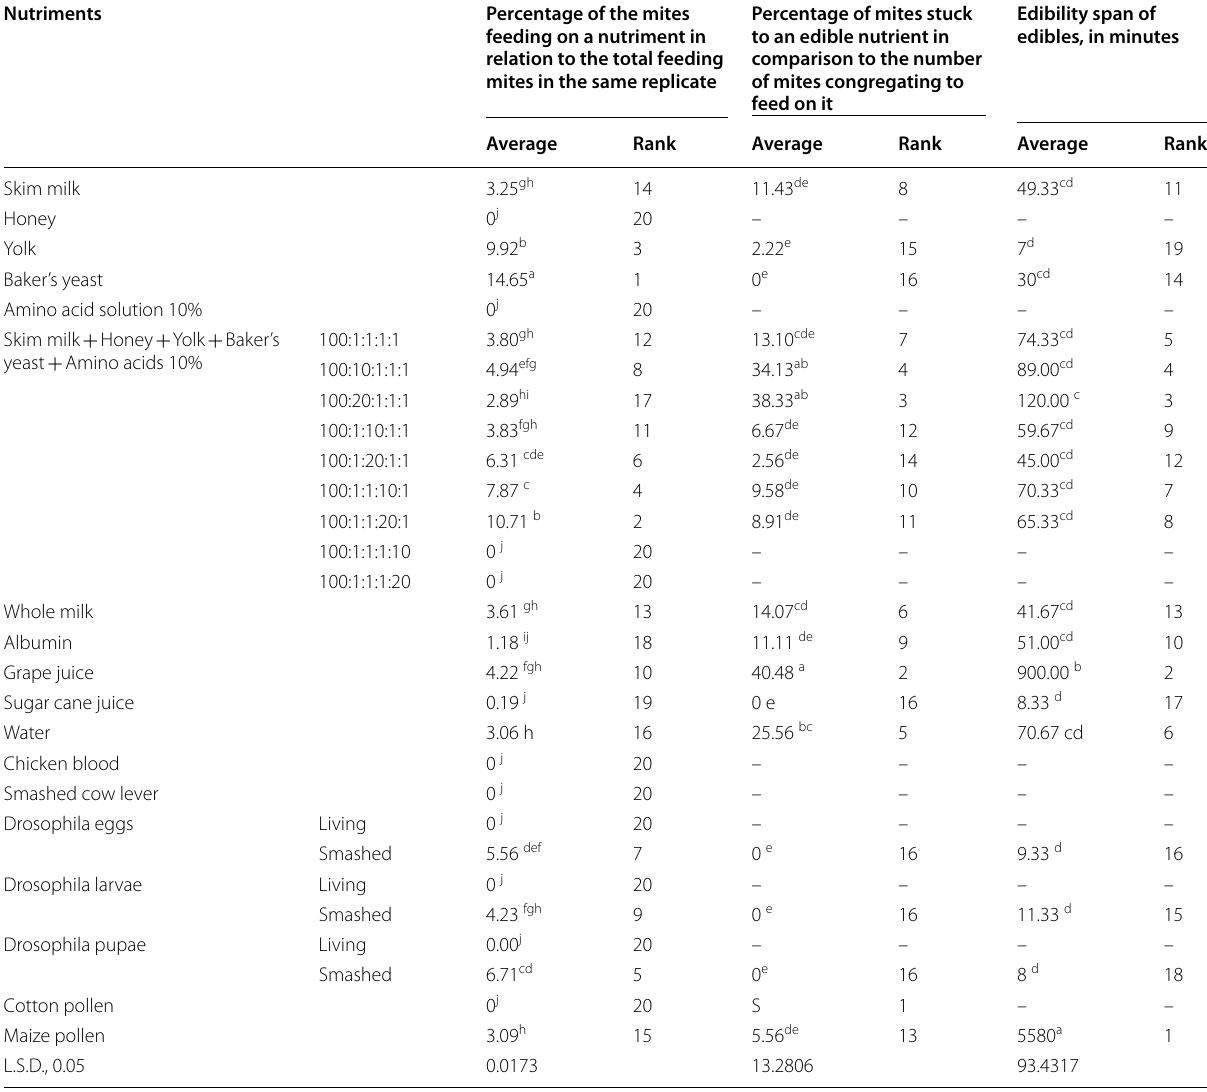
Significance for the superscript letters is located in the bottom row of the table Averages followed by the same letter in the same column are not significantly different at P < 0.05 level. Ranks are arranged in descending order S: Sticking without feeding